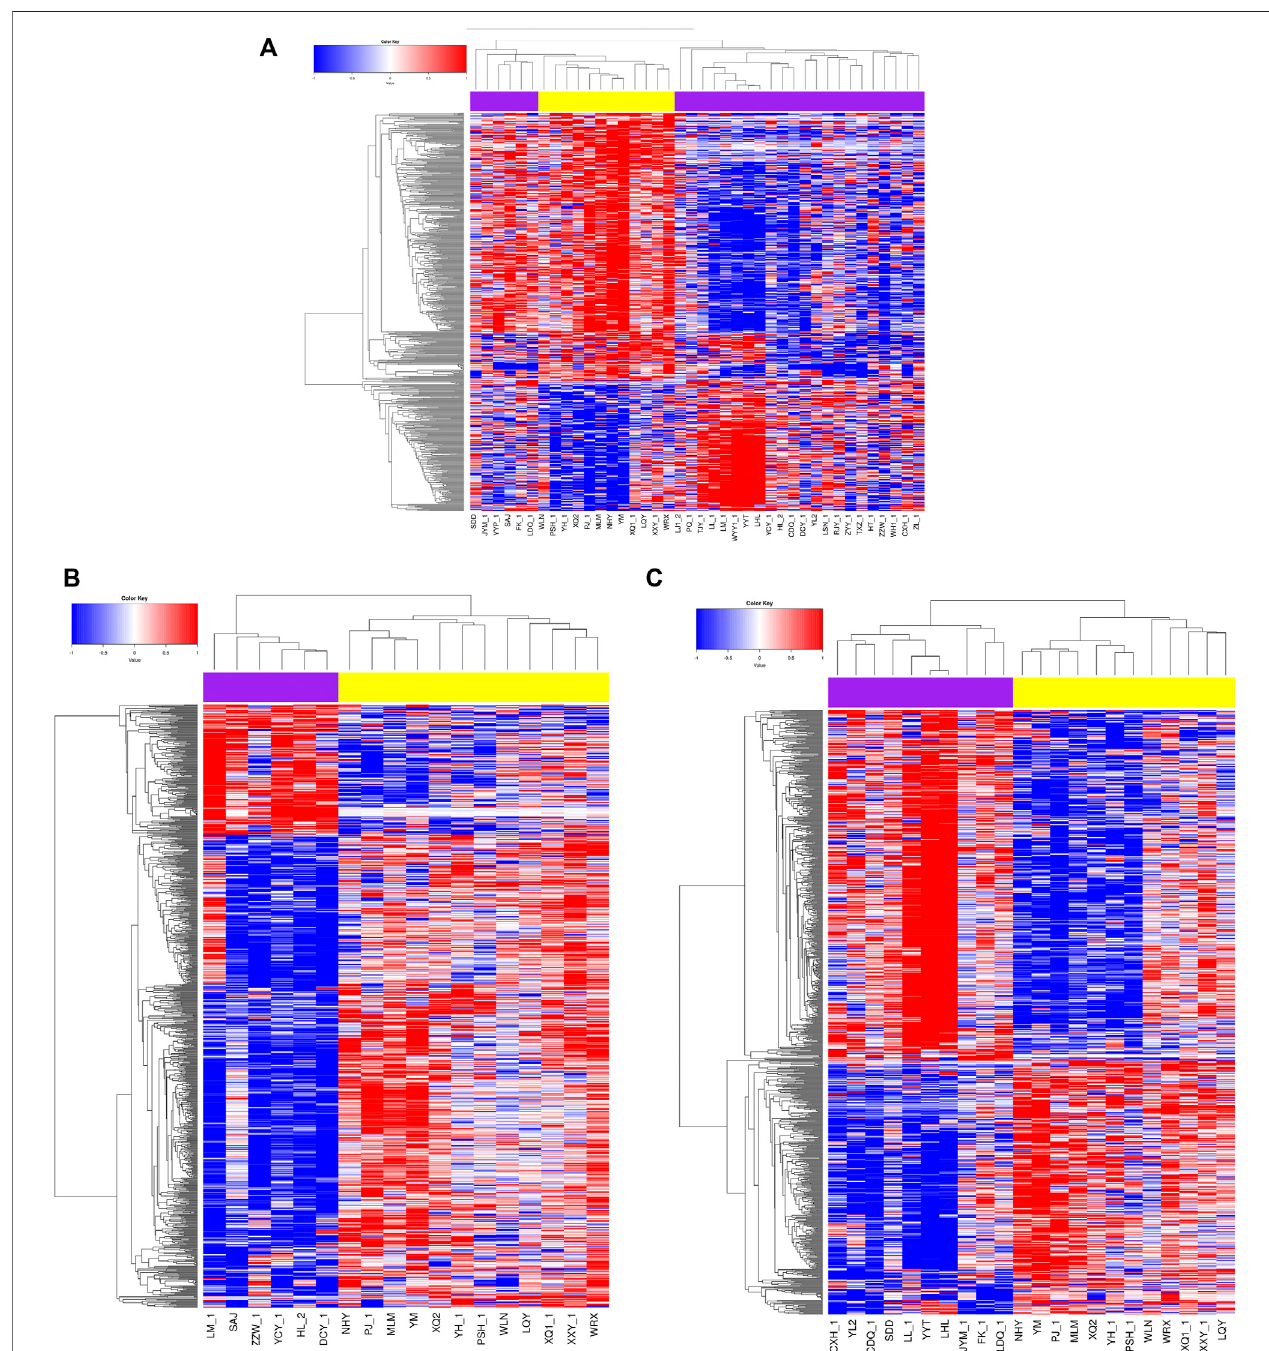
FIGURE 1 | Heat map showing the differential methylation levels of CpG loci in placental DNA of cases compared with normal controls. Red represents hypermethylation,bluerepresentshypomethylation,thepurplearethecases,theyellowarecontrols. (A) CTDsvs.controls; (B) TOFvs.controls; (C) DORVvs.controls; (D) TGA vs. controls; (E) PAVSD vs.